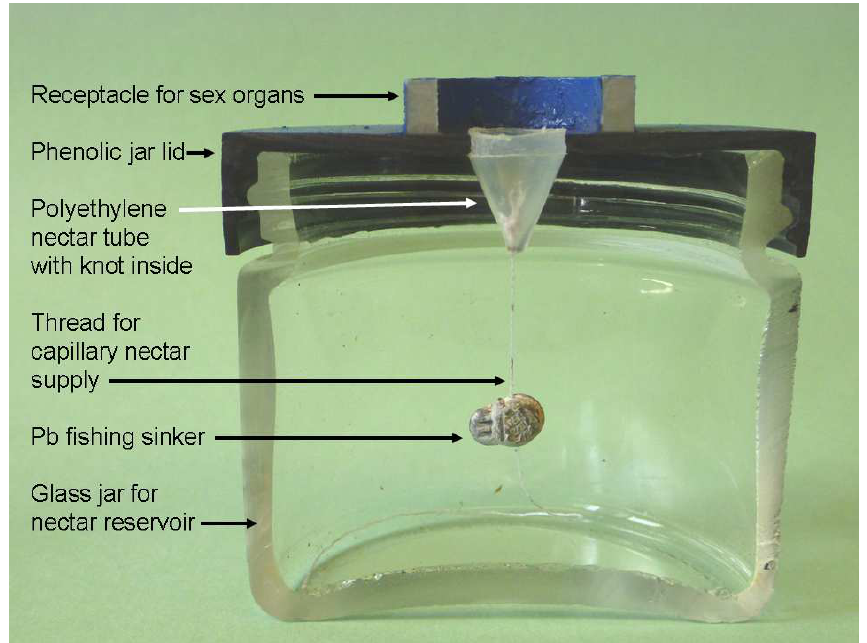
F IGURE 1. Cross-section of the basic dye-donating capillary